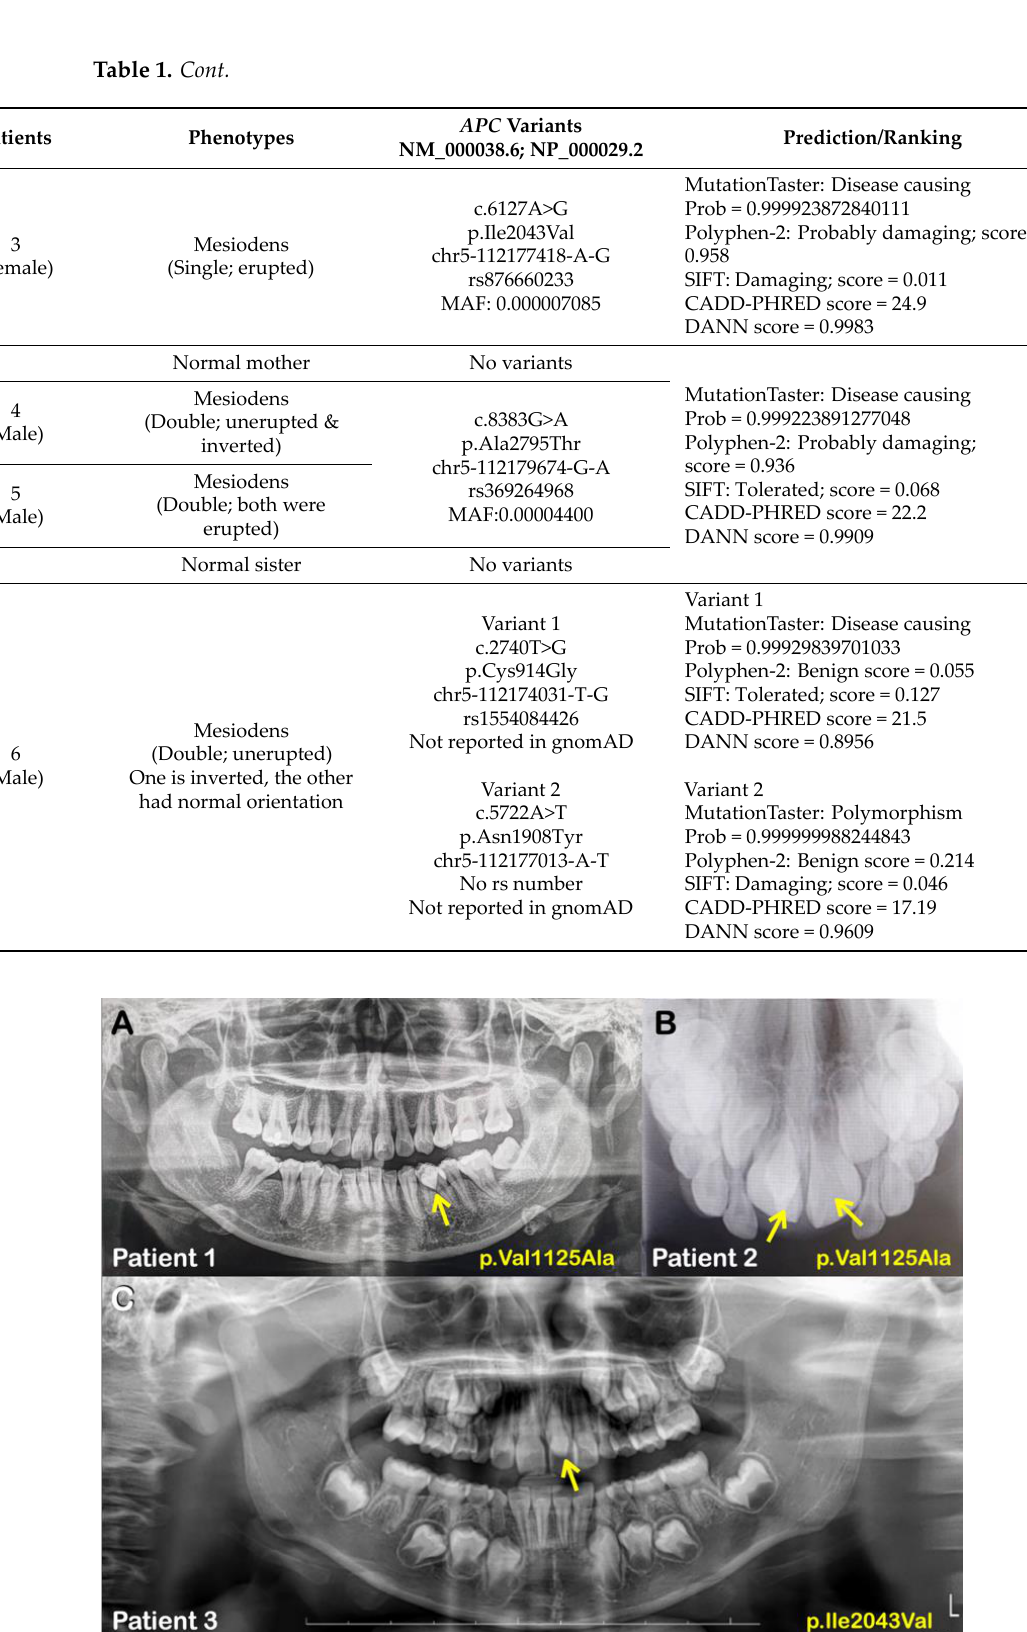
Figure 2. ( A ) Patient 4. Periapical radiograph showing double mesiodentes (inverted) (arrows). ( B ) Patient 5. Panoramic radiograph showing a mesiodens (arrow) and taurodontism (asterisk). ( C ) Pa- tient 6. Panoramic radiograph showing double mesiodentes (arrows) and taurodontism (asterisks).